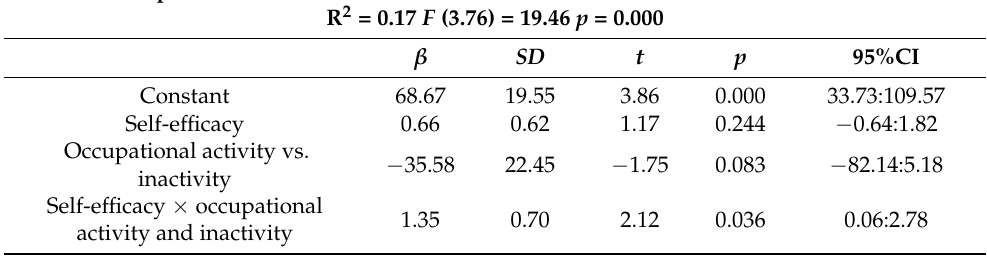
Table 5. Occupational activity as a moderator of relationships between self-efficacy and the perceived function of work for mental health. Explained Variable: The Perceived Function of Work for Mental Health R 2 = 0.17 F (3.76) = 19.46 p =